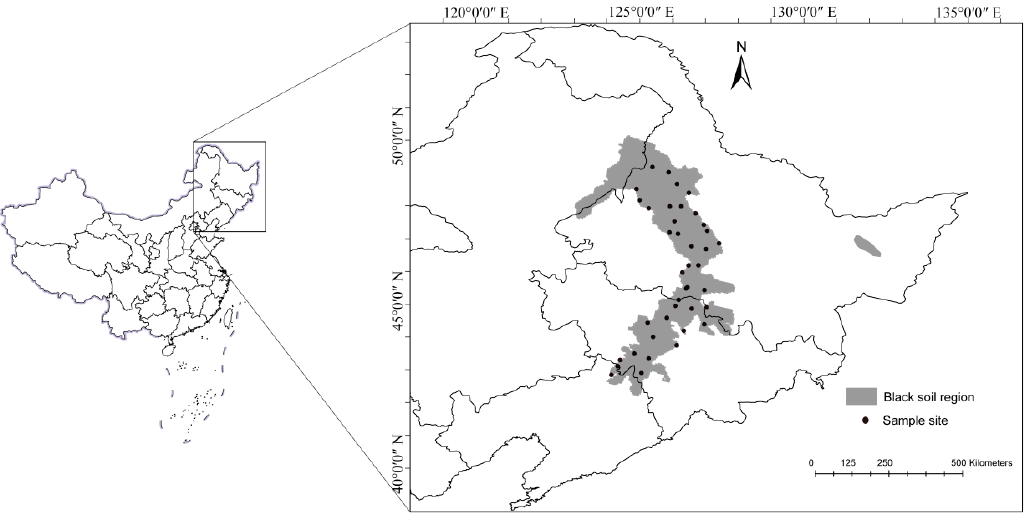
Figure 1. Location of the study area and distribution of 41 sampling sites. The gray region indicates the representative black soil region of northeast China. The black circles represent the sampling sites.